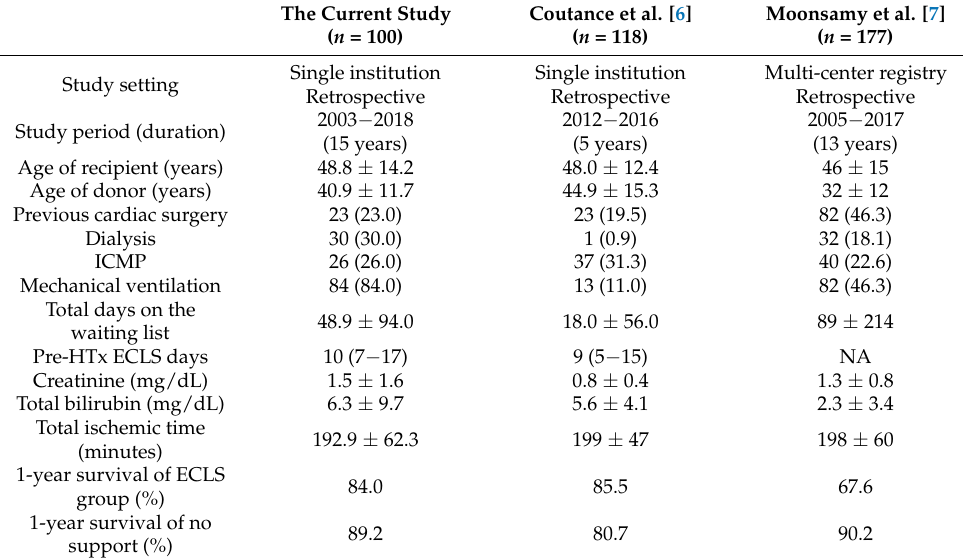
Table 5. Comparison of recent and current